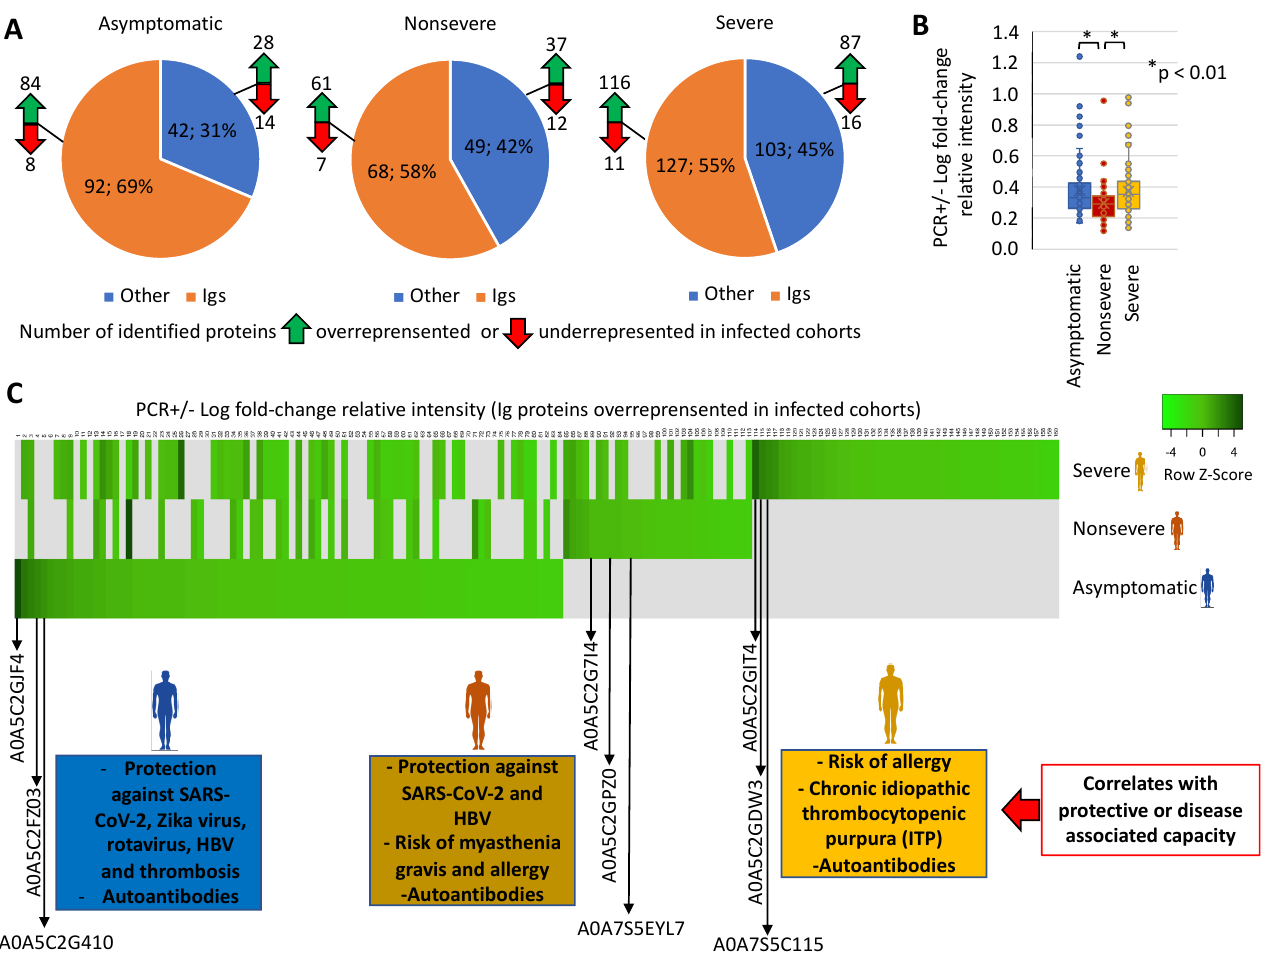
Figure 2. Serum-protein profiles and correlation of Ig overrepresented in vaccinated infected co- horts with protective- or disease-associated capacity. ( A ) Number of identified overrepresented or underrepresented Ig and non-Ig proteins in infected asymptomatic, non-severe, and severe cohorts when compared to PCR– individuals. ( B ) Change in Ig-protein levels in PCR+ cohorts. PCR+/ − Log fold-change relative intensity was compared between groups by One-way ANOVA test followed by post-hoc Bonferroni and Holm multiple comparisons tests ( p < 0.05). ( C ) Heatmap of PCR+/− Log fold-change relative intensity (Z-scored original value) for Ig proteins overrepresented in infected cohorts. Correlates with protective- or disease-associated capacity are shown for Igs highly overrepresented in PCR+ individuals.